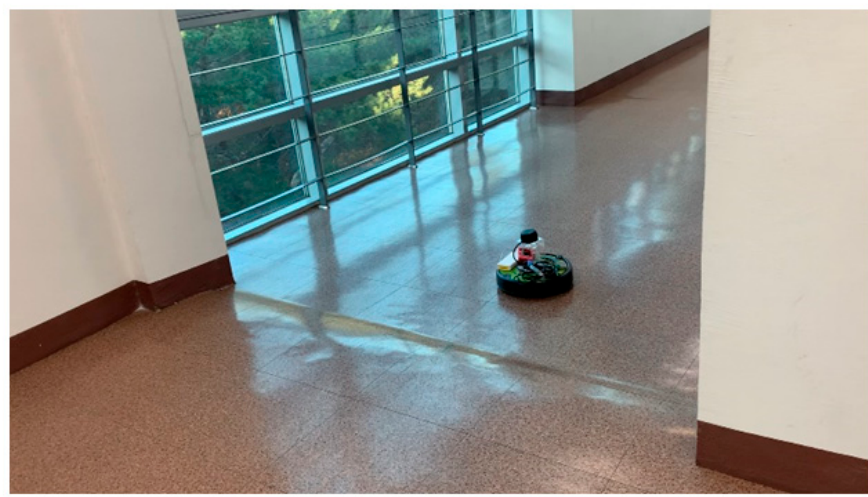
Figure 32. Position (marked 5 in Figure 29) in indoor space where third autonomous scanning experiment was performed.